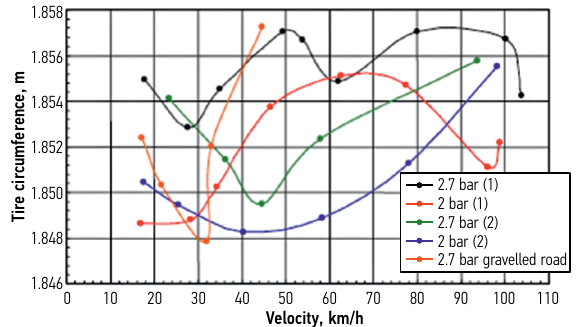
Fig. 7. Experimental ABS sensor data with various tire pressures and different road temperatures